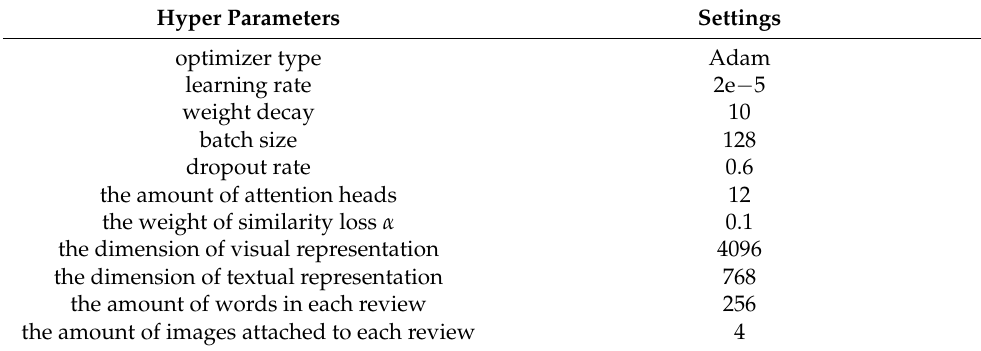
Table 2. Settings of the hyper parameters.